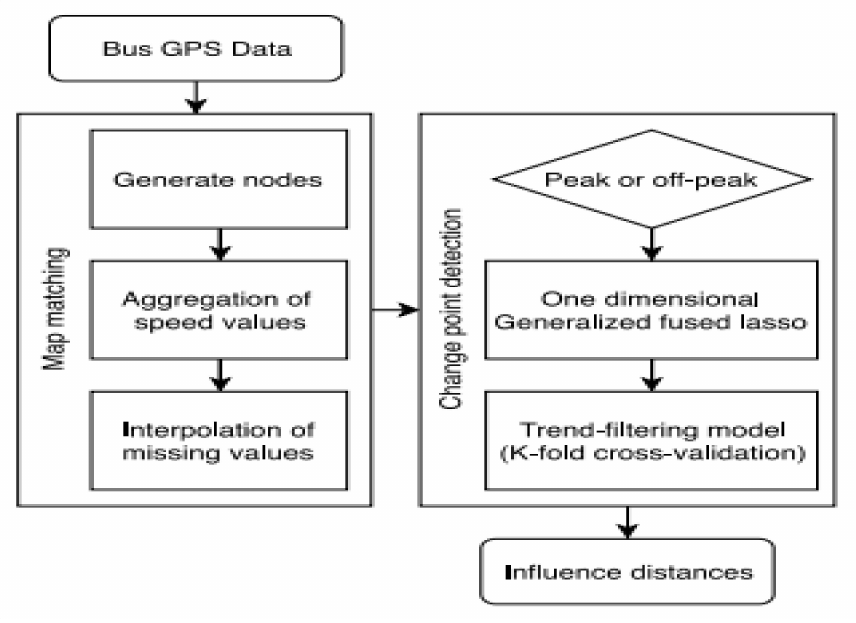
Figure 16. Data preprocessing with map matching